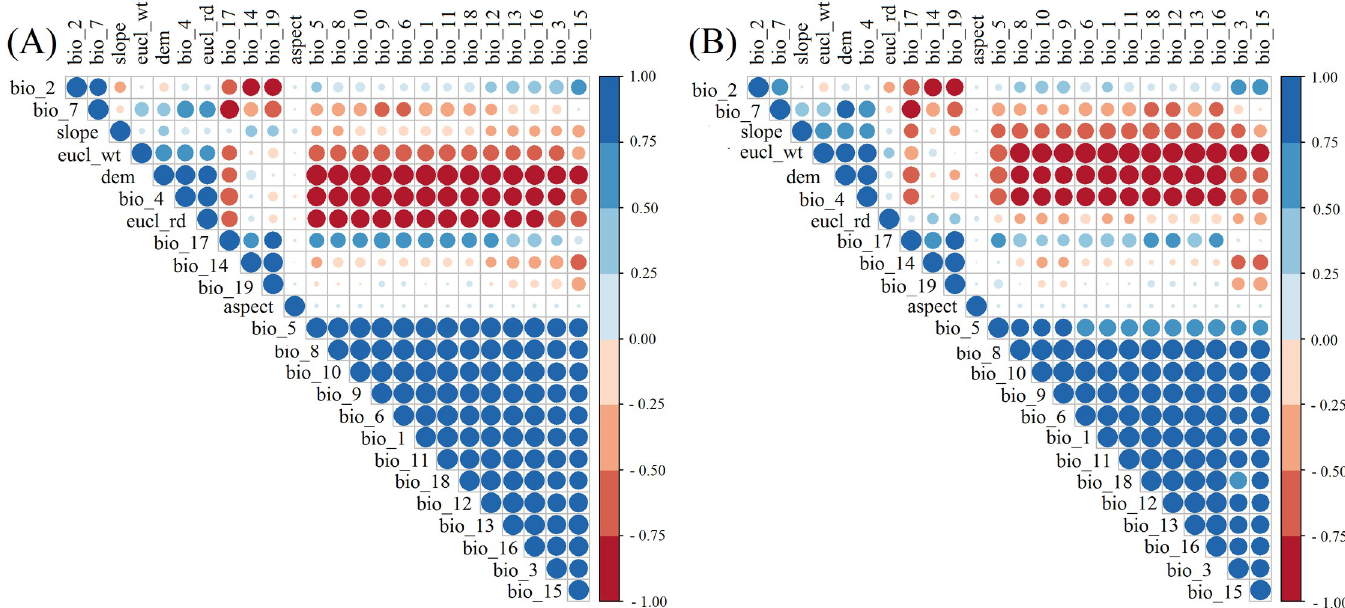
Fig 2. Representation of Pearson correlation matrix for environmental data of the “current” year (A) and year 2050 (B).